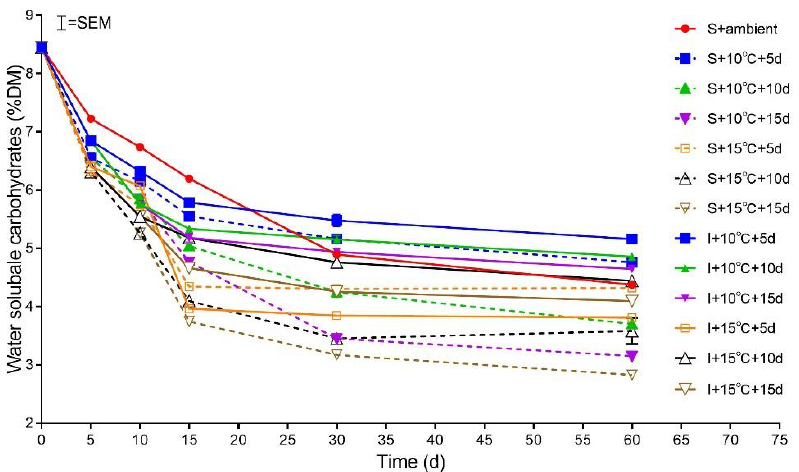
Figure 4. Dynamics of WSC in silage inoculated with inherent LAB (I) and commercial LAB (S) and stored at ambient temperature and stage-increased temperatures of 10 °C and 15 °C for 5, 10 and 15 days, respectively.